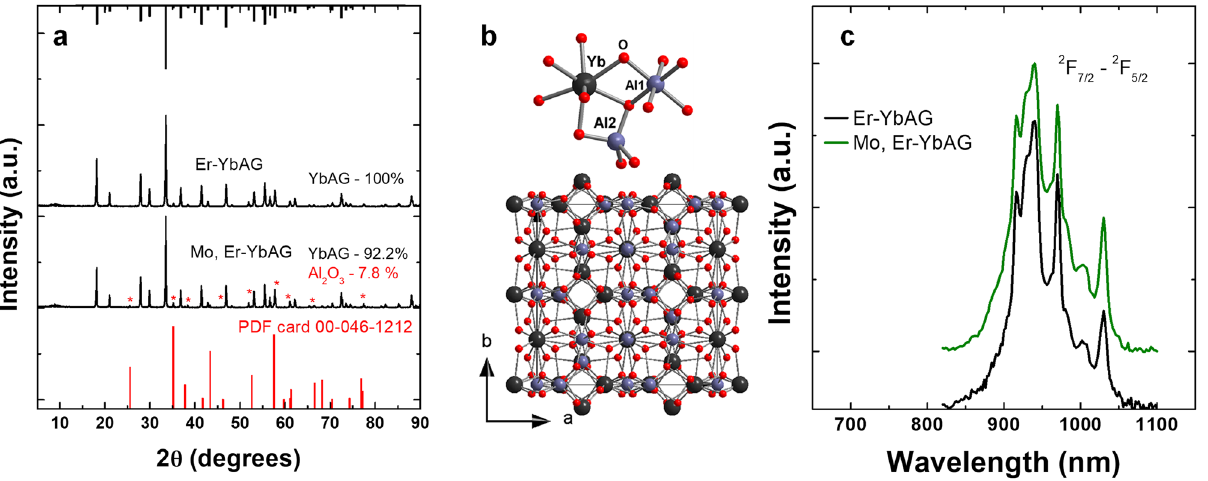
Figure 1. ( a ) XRD patterns, ( b ) Structural representation of YbAG lattice and ( c ) Diffuse reflectance spectra of (Mo) Er- YbAG in the region of Yb 2 F 7/2 - 2 F 5/2 absorption transition. All XRD patterns and Diffuse reflectance spectra were normalized at maximum intensity for comparison